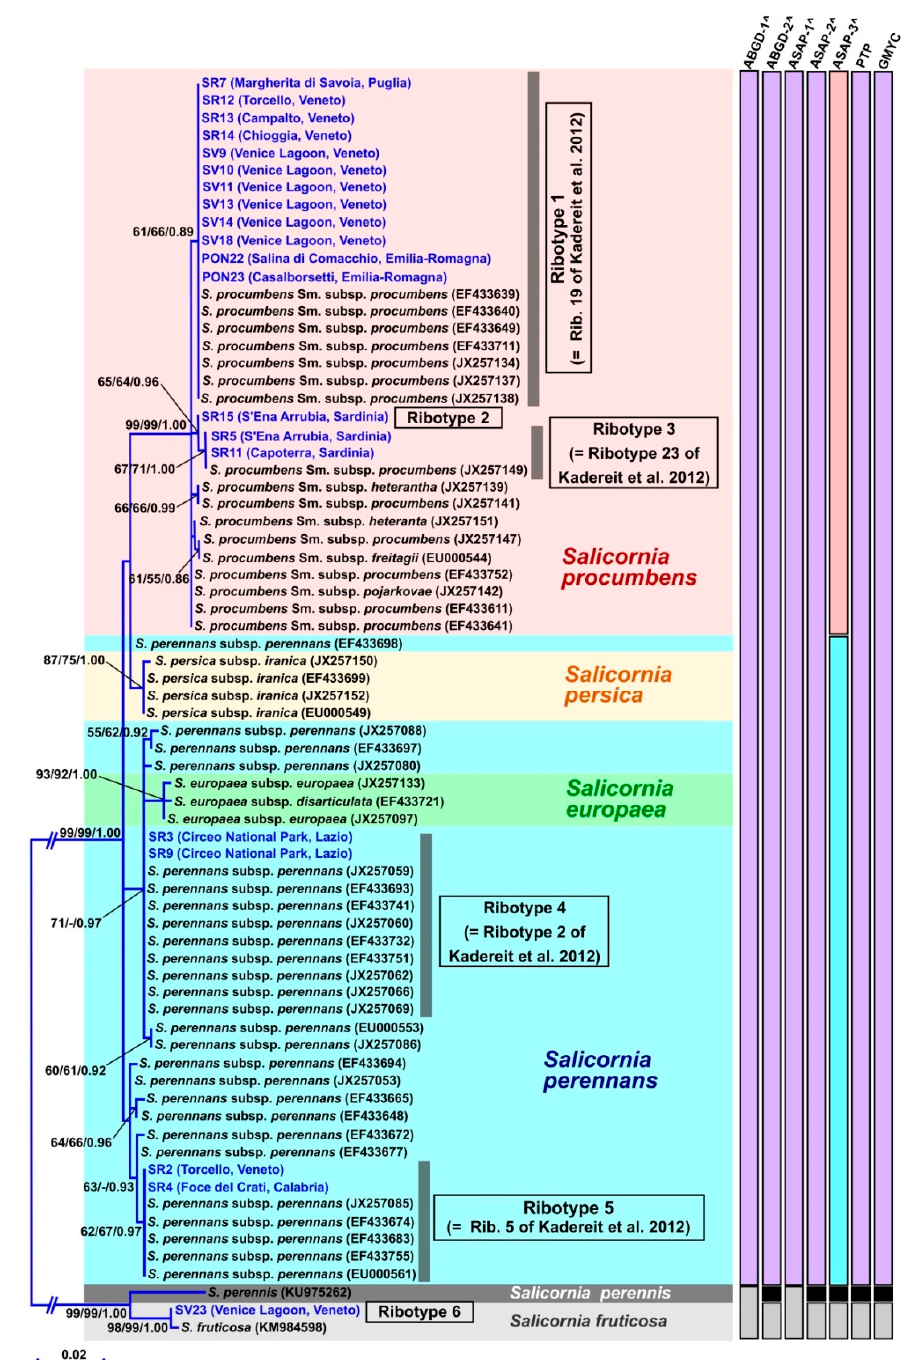
Figure 2. Phylogenetic reconstruction based on the ETS region. For each node, the support values from ML bootstrap and MP bootstrap and BI posterior probabilities are reported, respectively. Only bootstrap supports ≥ 50% and posterior probabilities ≥ 0.70 are shown. Values for nodes that obtained support in only one of the phylogenetic analyses were omitted. For each of the downloaded sequences, the species name, followed by the INSDC accession number, is reported. The sequences obtained in this study are highlighted in blue colour and the Italian ribotypes are indicated. Scale bar represents expected number of nucleotide substitutions per site. The results of the species delimitation tests are reported on the right; for ABGD the first two results are reported, and for ASAP the first three results are indicated. Comparison between the detected Italian ribotypes and those of Kadereit et al. [7] were